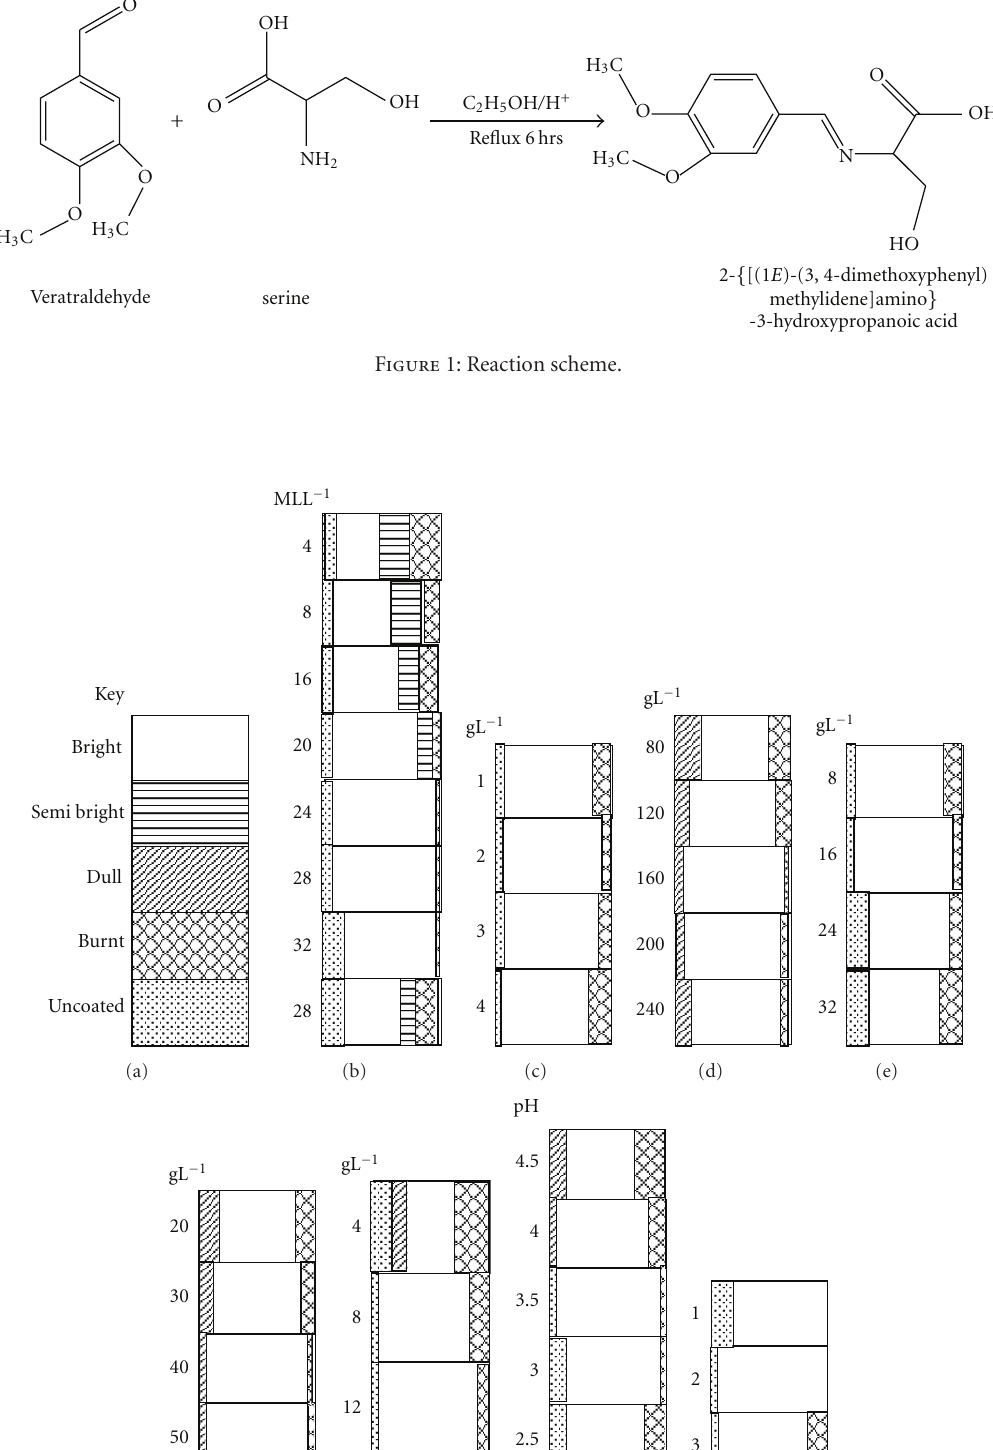
Figure 1: Reaction scheme.